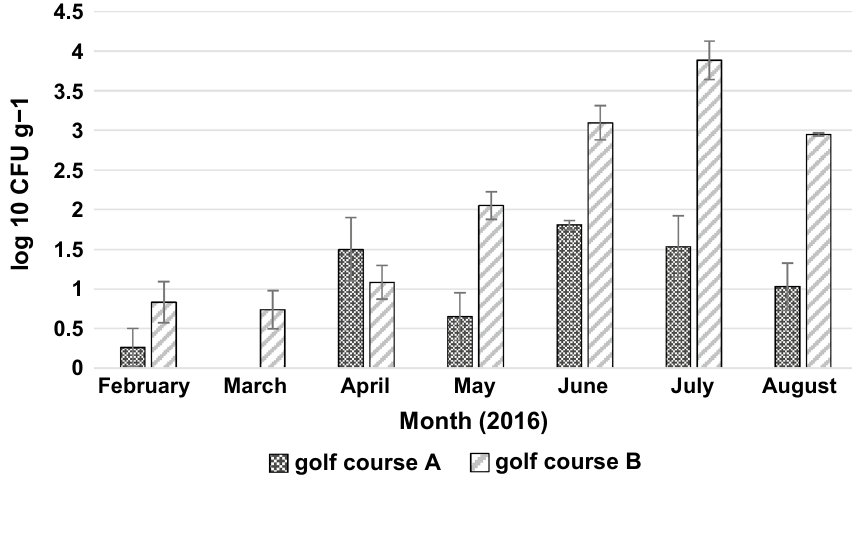
Fig. 11 Monthly variation of